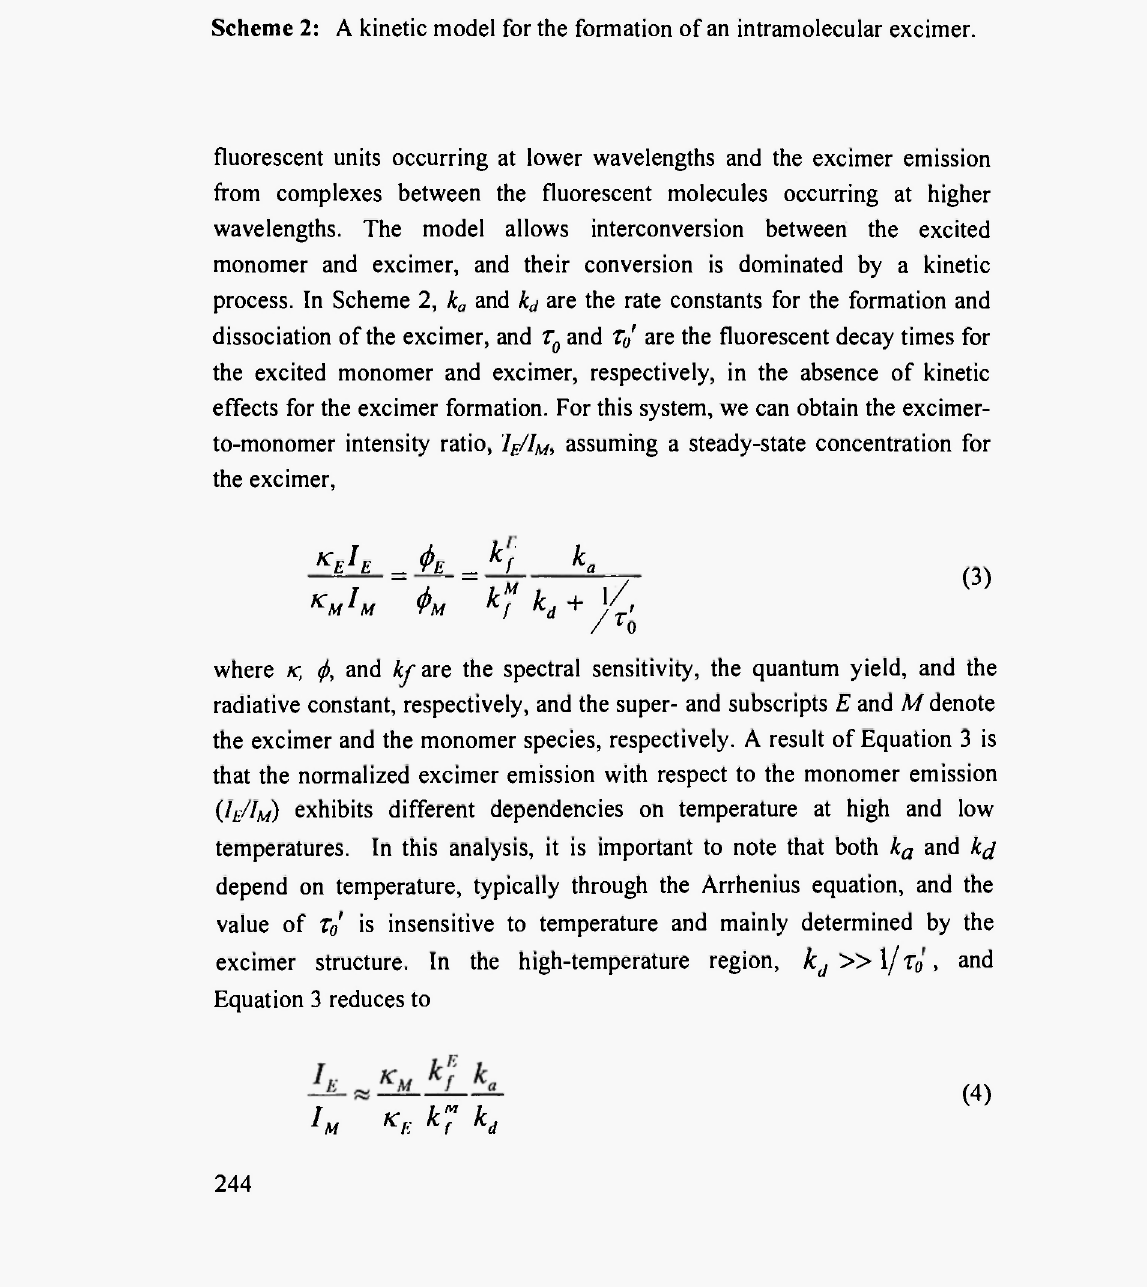
fluorescent units occurring at lower wavelengths and the excimer emission from complexes between the fluorescent molecules occurring at higher